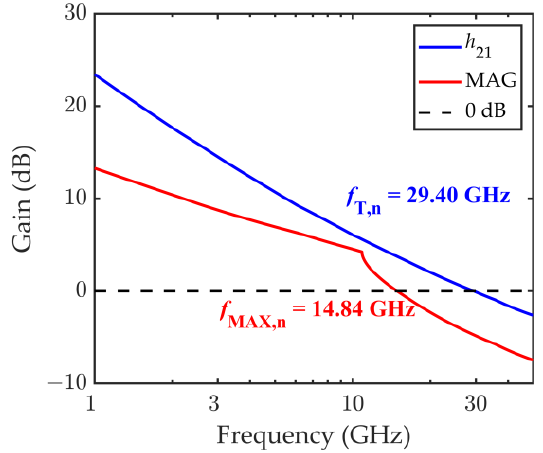
Figure 4. Short-circuit current gain h 21 and maximum available gain MAG computed in correspondence of the nominal set of input parameters, at the bias point V GS = −0.2 V, V DS = −1.2 V. The nominal cut-off frequency is f T,n = 29.40 GHz, and the nominal maximum oscillation frequency is f MAX,n = 14.84 GHz.